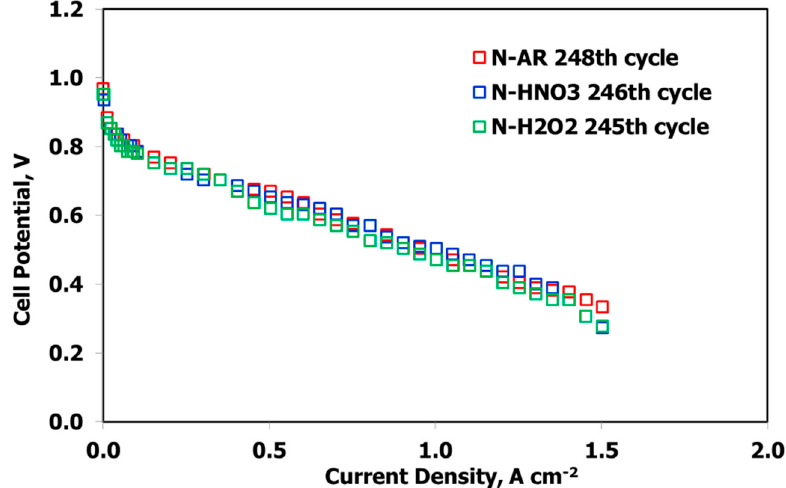
Figure 9. I–V curves at EoT at 80 °C, 100% RH, 1.5 abs bar: 248 cycles for N-AR (red squares), 246 cycles for N-HNO3 (blue squares), 245 cycles for N-H2O2 (green squares).